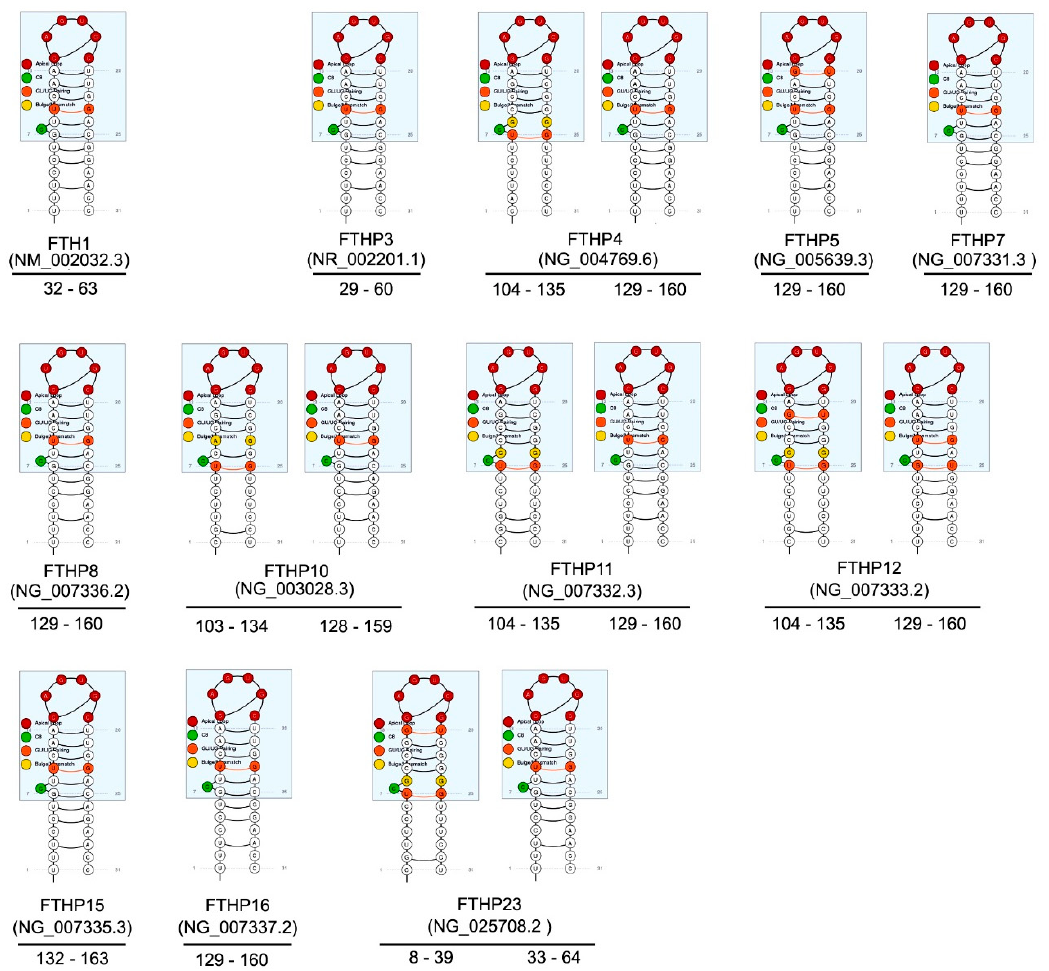
Figure 1. Predicted iron-responsive elements (IREs) in FTH1 pseudogenes as retrieved by SIREs Server v2.0 [68]. For comparison, the upper left IREs structure refers to FTH1 gene. The nucleotide positions of IREs in respect to the NCBI reference sequence are reported below each structure. Colored circles are as follows: red, Apical loop; green, Cytosine position 8 (C8); orange, GU/UG pairing; yellow, Bulge/Mismatch. Abbreviations used: FTH1P3, ferritin heavy chain 1 pseudogene 3; FTH1P4, ferritin heavy chain 1 pseudogene 4; FTH1P5, ferritin heavy chain 1 pseudogene 5; FTH1P7, ferritin heavy chain 1 pseudogene 7; FTH1P8, ferritin heavy chain 1 pseudogene 8; FTH1P10, ferritin heavy chain 1 pseudogene 10; FTH1P11, ferritin heavy chain 1 pseudogene 11; FTH1P12, ferritin heavy chain 1 pseudogene 12; FTH1P15, ferritin heavy chain 1 pseudogene 15; FTH1P16, ferritin heavy chain 1 pseudogene 16; FTH123, ferritin heavy chain 1 pseudogene 23.